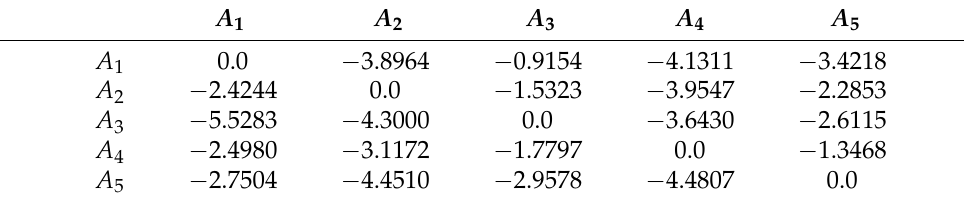
Table 14. Global dominance of A i over A j .